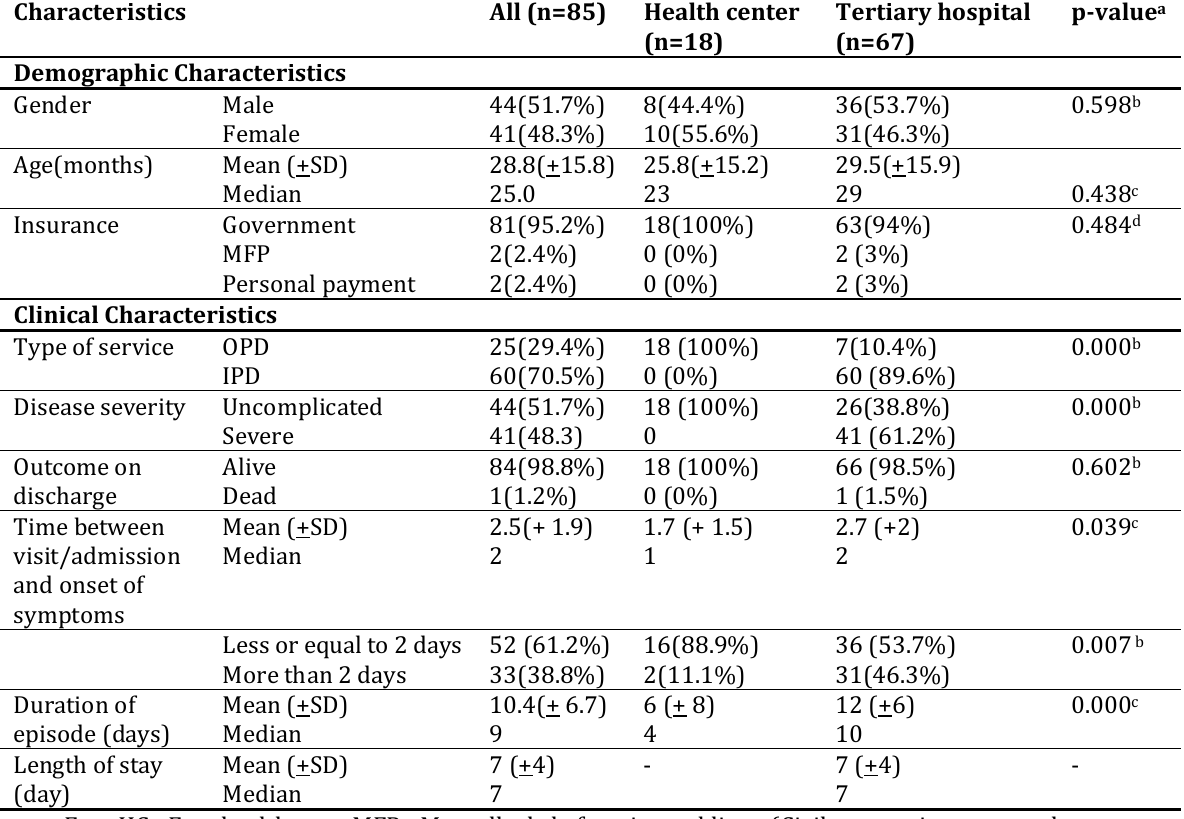
Table 1: Baseline characteristics of the study